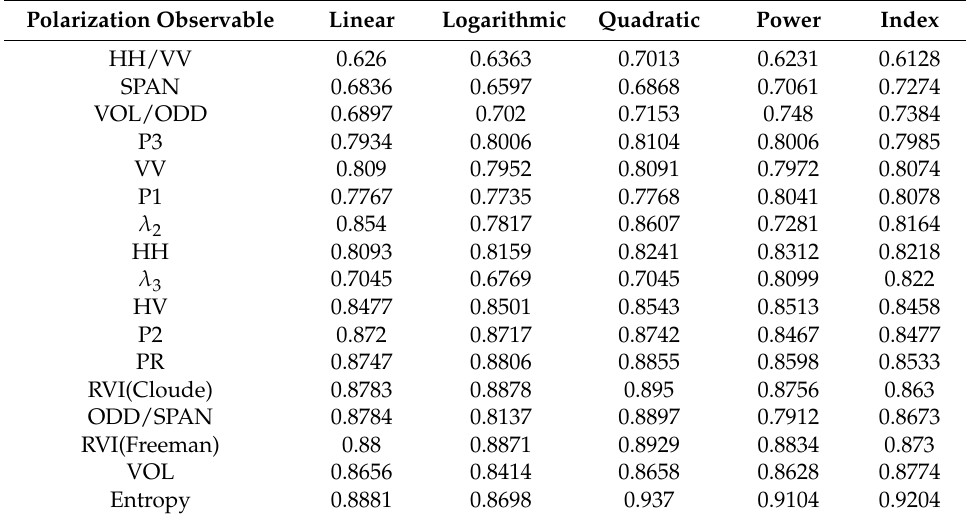
Table 6. Coefficients of determination (r 2 ) of five empirical regression models for stem height inversion.